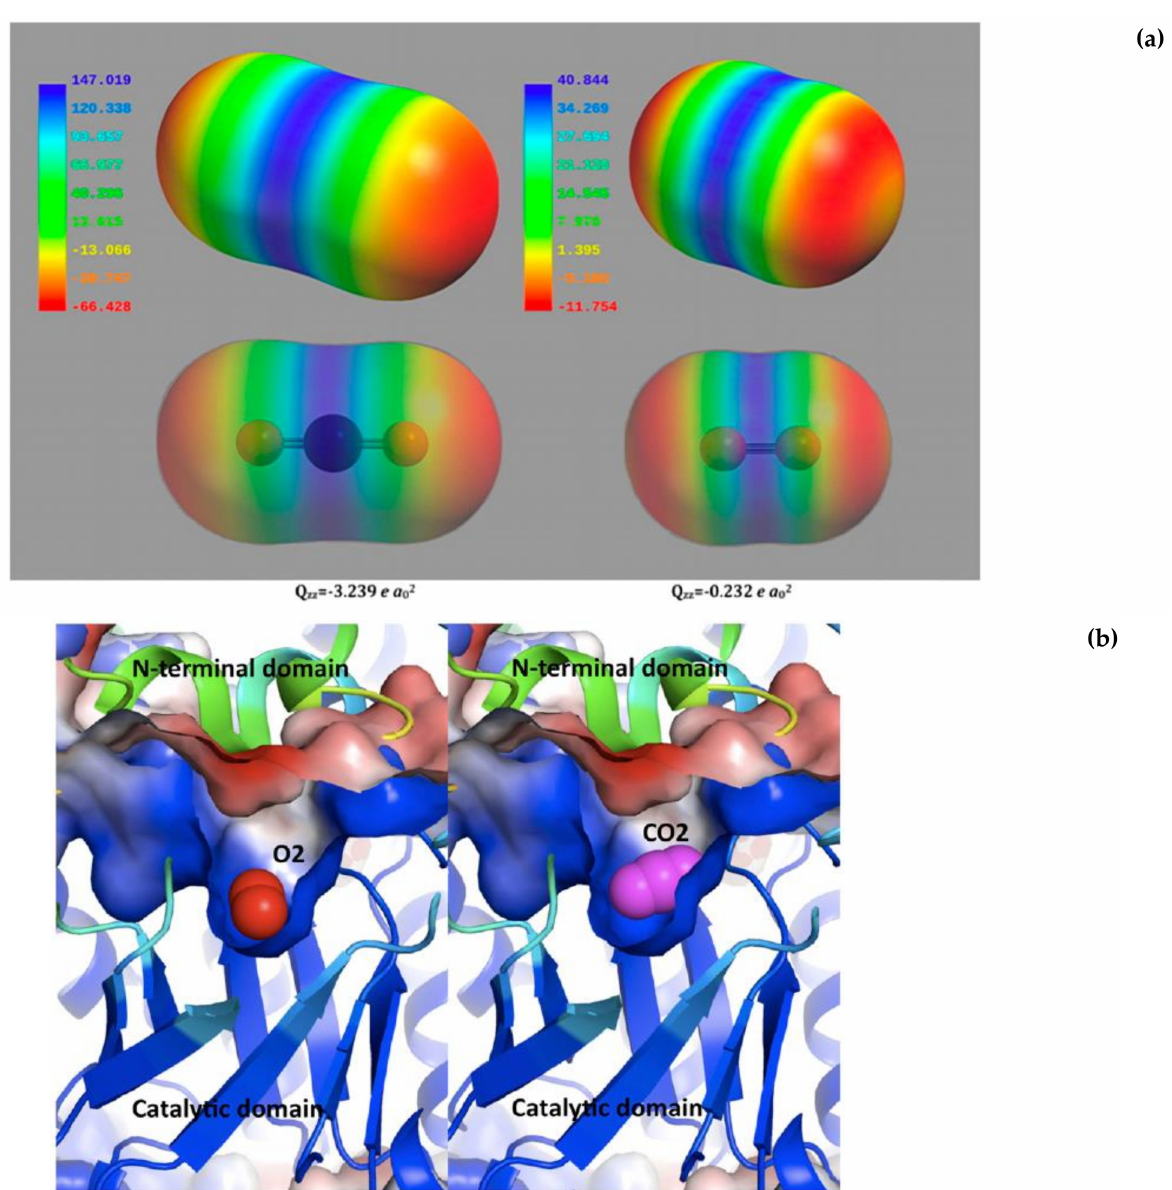
Figure 6. ( a ) Computed electrostatic potential molecular surfaces of CO 2 (left) and O 2 (right). The color scheme follows commonly accepted conventions: blue, positive; red, negative. The value of the Qzz component of the quadrupole moment, as calculated by Stec, is − 3.239 e a 02 for CO 2 and − 0.232 e a 02 for O 2 ; ( b ) a ribbon representation of the catalytic domain with bound gaseous ligands and surfaces colored by the electrostatic potential. O 2 (in red) and CO 2 (in purple) lie in a positively charged cavity (blue) of the TIM barrel. (Figure from ref. [15], used by permission of PNAS (copyright ©